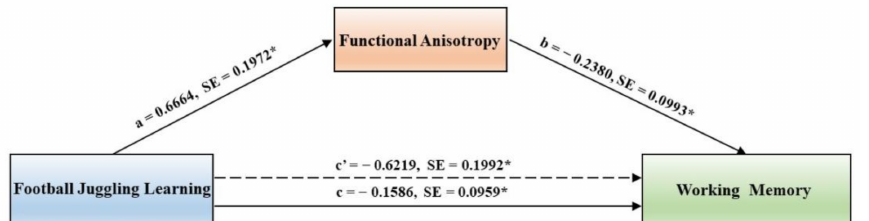
Figure 2. FA mediated the association between motor learning and working memory. Depiction of the applied mediation model: Unstandardized coefficients and standard errors for each path of the mediation model are presented. Note that c represents the direct effect while c’ denotes the indirect effect. * indicates significance at p <